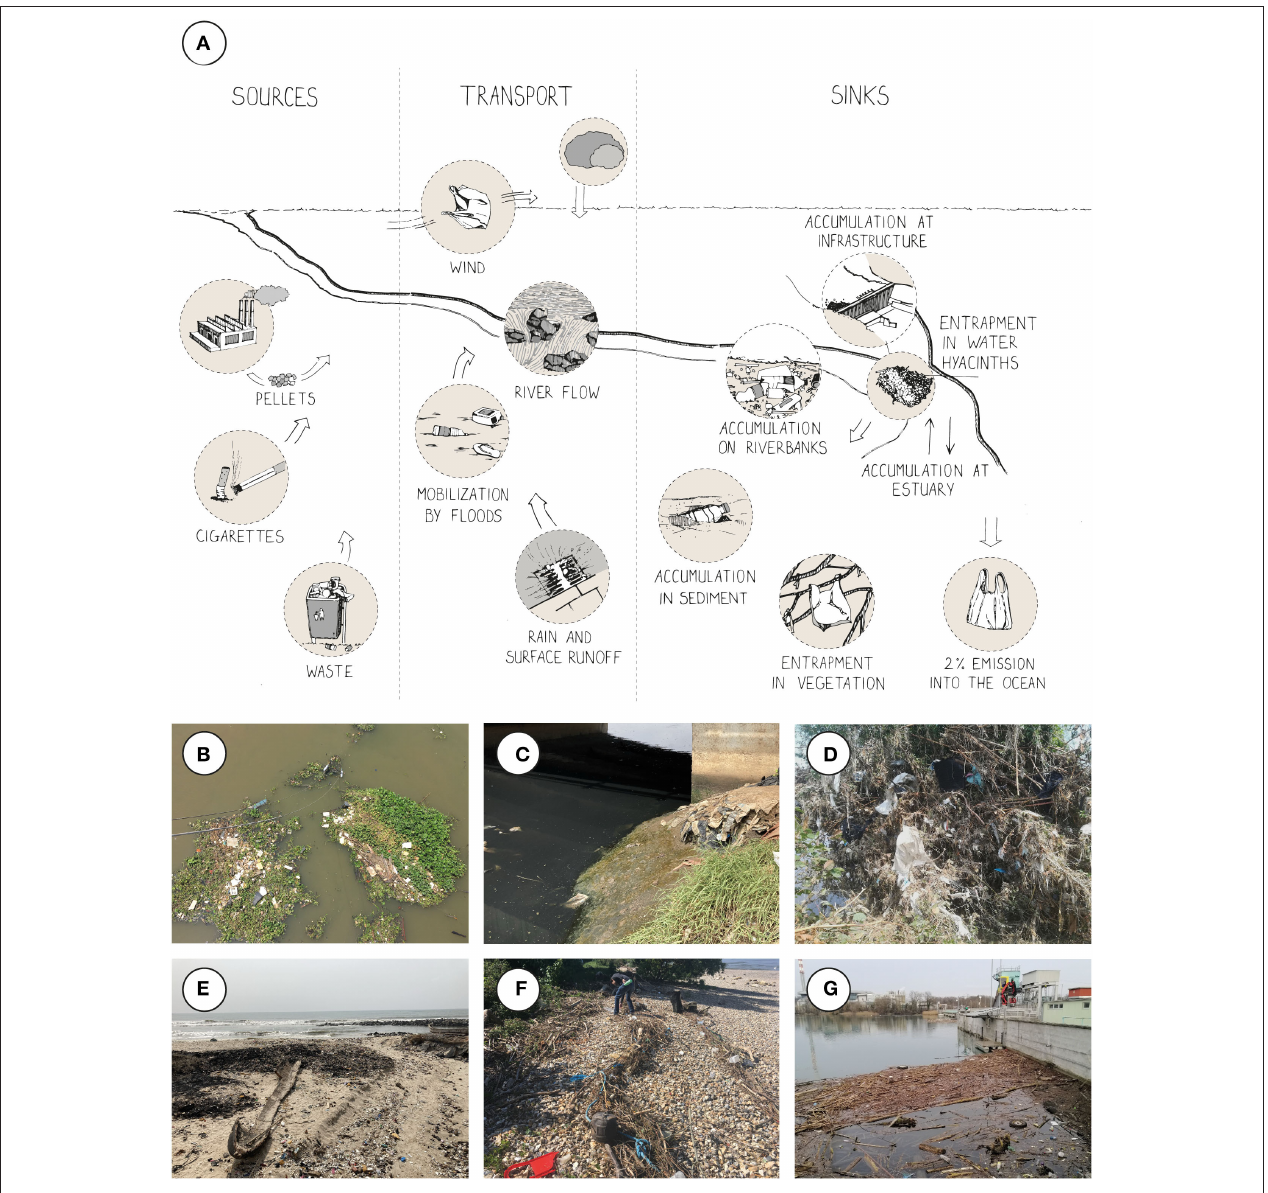
FIGURE 1 | (A) Conceptual overview of sources, transport mechanisms and sinks (retention zones) of river plastic pollution (Graphic design by Cher van den Eng). Sources include mismanaged plastic waste, littering from individuals (e.g., cigarette butts), and leakage from industry (e.g., pellets). Transport processes include wind, surface runoff, river flow dynamics, and floods. Retention zones include infrastructure, stationary and mobile vegetation (the latter illustrated by the water hyacinth), riverbanks, and the estuary. Finally, only < 2% is estimated to be emitted into the ocean globally. The photos show examples of plastic retention (B) in water hyacinth (Saigon river, Vietnam), (C) within riverbank sediments, (Odaw river, Ghana), (D) in riparian vegetation (Meuse river, the Netherlands), (E) in the estuary mouth (Odaw river, Ghana), (F) on riverbanks (Seine river, France), and (G) at infrastructure (Rhône river, Switzerland). All photos are taken by the